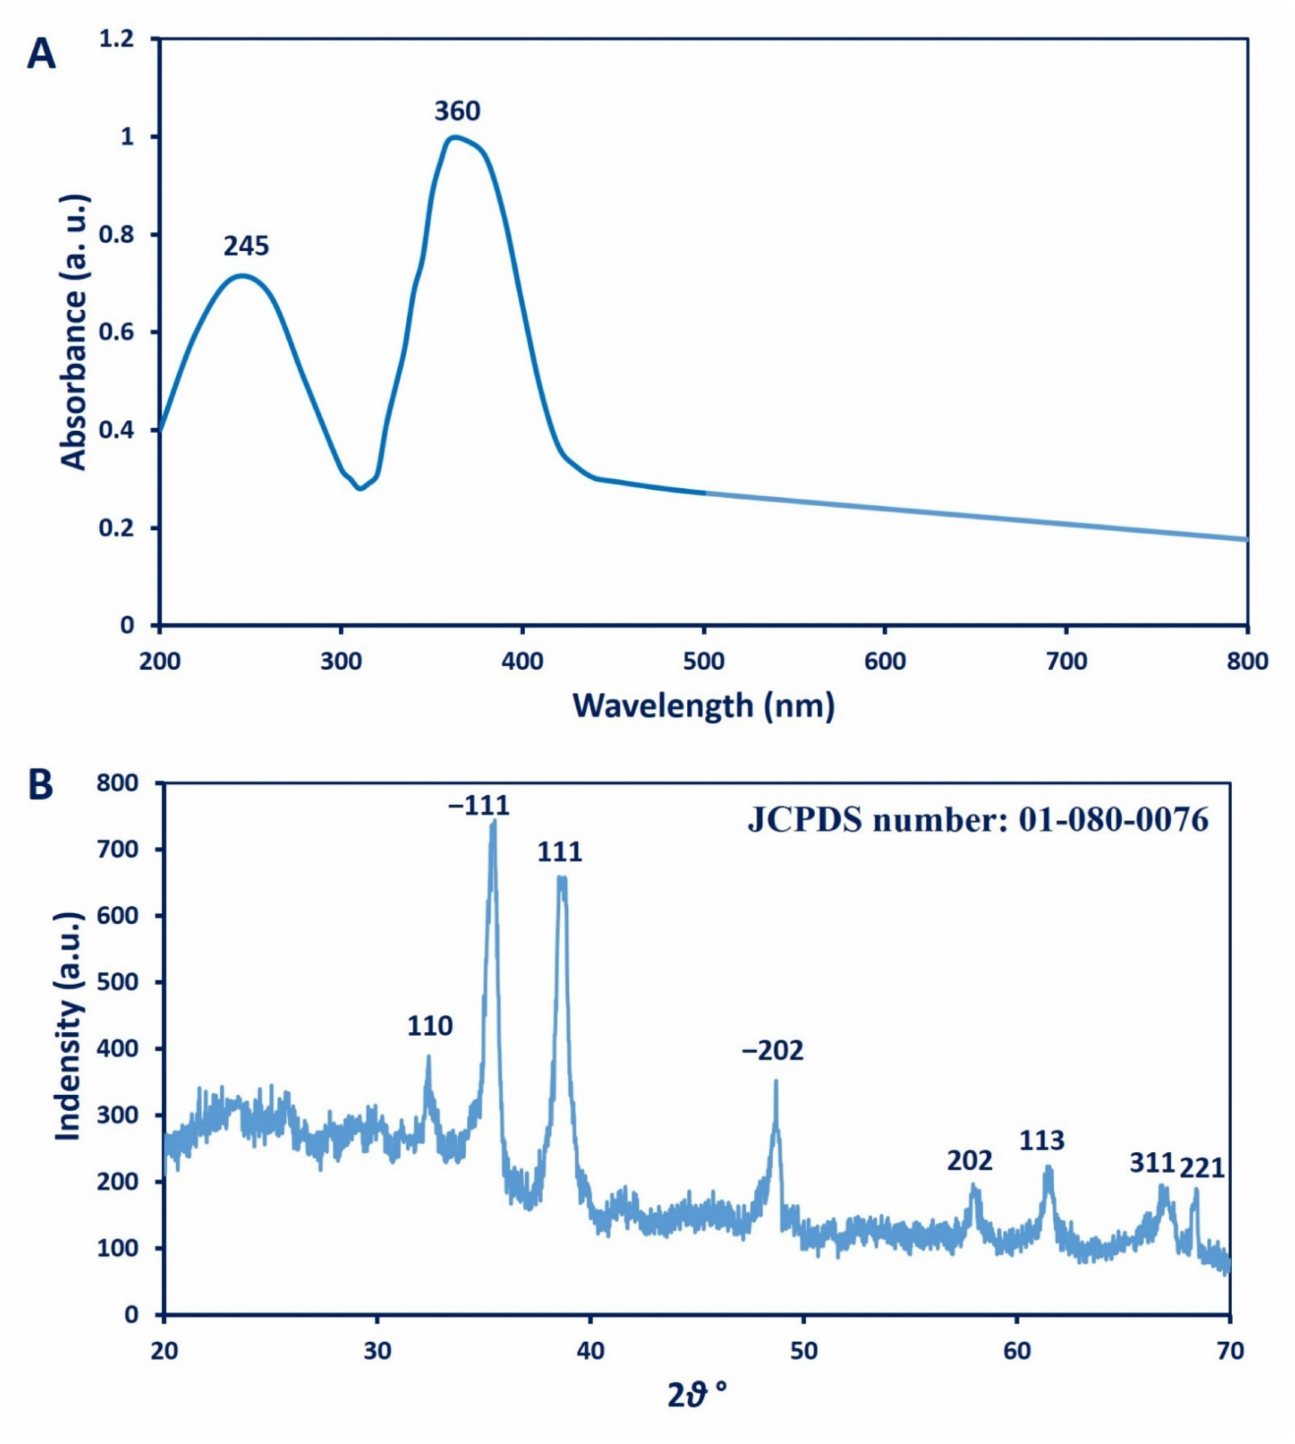
Figure 1. ( A ) UV–vis spectroscopic analysis of CuO-NPs synthesized by A. niger G3-1; ( B ) X-ray diffraction pattern of CuO-NPs showed intense peaks at specific 2 theta